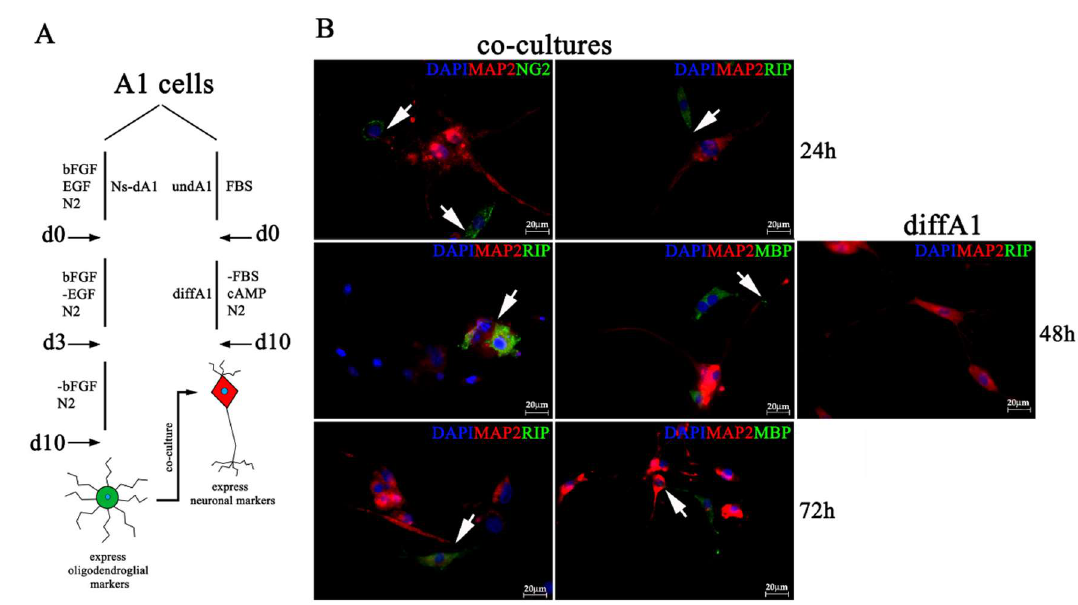
Figure 6. A1-derived oligodendrocytes preserved the expression of the oligodendroglial markers NG2 and RIP. ( A ) Ns cells differentiated for 10 days as shown in Figure 3A were directly added to A1 cells differentiated towards a neuronal phenotype for 10 days. ( B ) Co-cultures were immunolabeled with MAP2 (red), NG2 (green), RIP (green), MBP (green) and DAPI nuclei (blue) after 24, 48 and 72 hours. NG2 and RIP-positive cells extended processes that frequently reach MAP2- positive cells (arrows). No RIP-positive cells were found in A1 cells differentiated (diffA1) towards a neuronal phenotype. Scale bar = 20 µ m. Magnification 63 ×